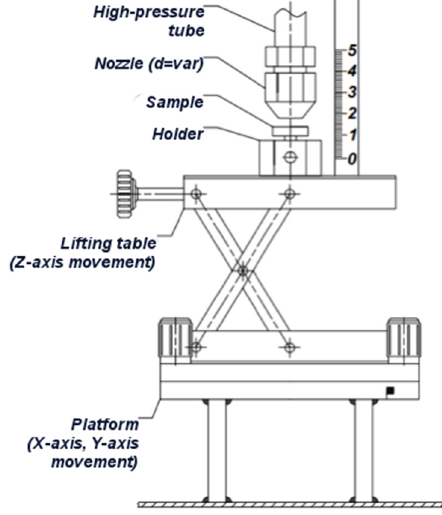
Figure 3. Diagram of sample positioning system in chamber of cavitation jet test rig.